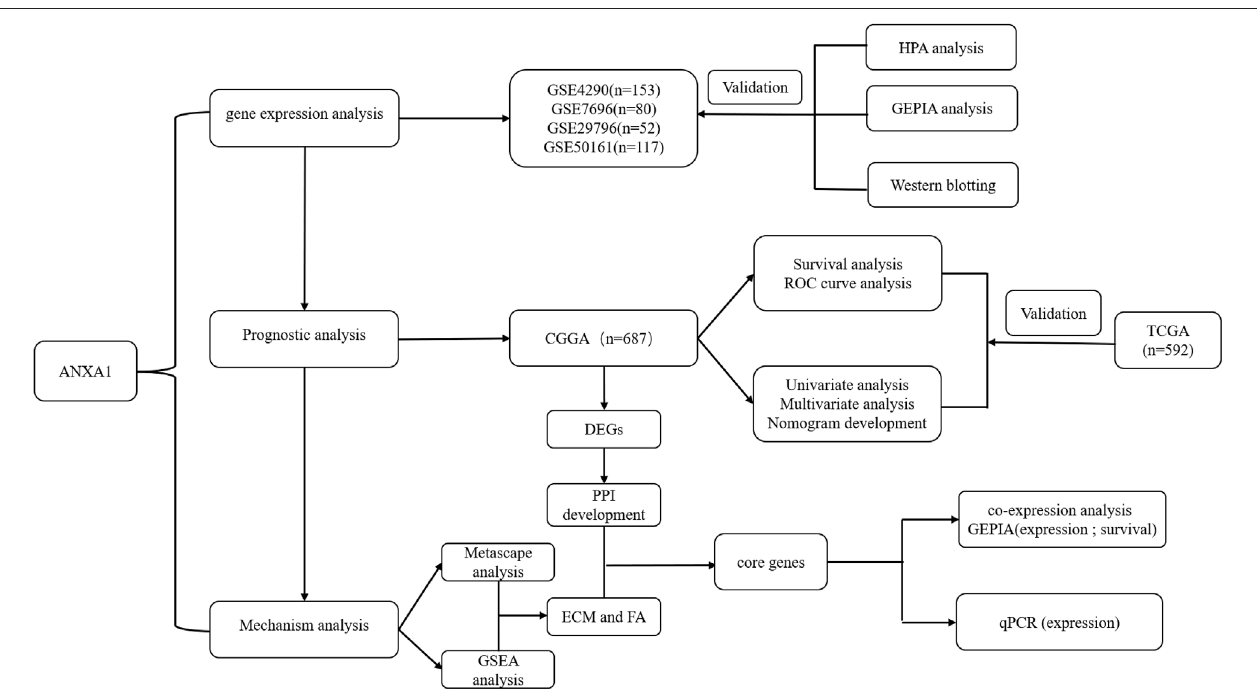
FIGURE1| Workingdiagramofthestudy.Abbreviations:GEO:GeneExpressionOmnibus;CGGA:ChineseGlioma GenomeAtlas;DEGs:differentially expressed genes; GSEA: Gene Set Enrichment Analysis; PPI: protein – protein interaction; ECM: extracellular matrix; FA: focal adhesion; HPA: Human Protein Atlas; GEPIA: Gene Expression Pro fi ling Interactive Analysis; TCGA: The Cancer Genome